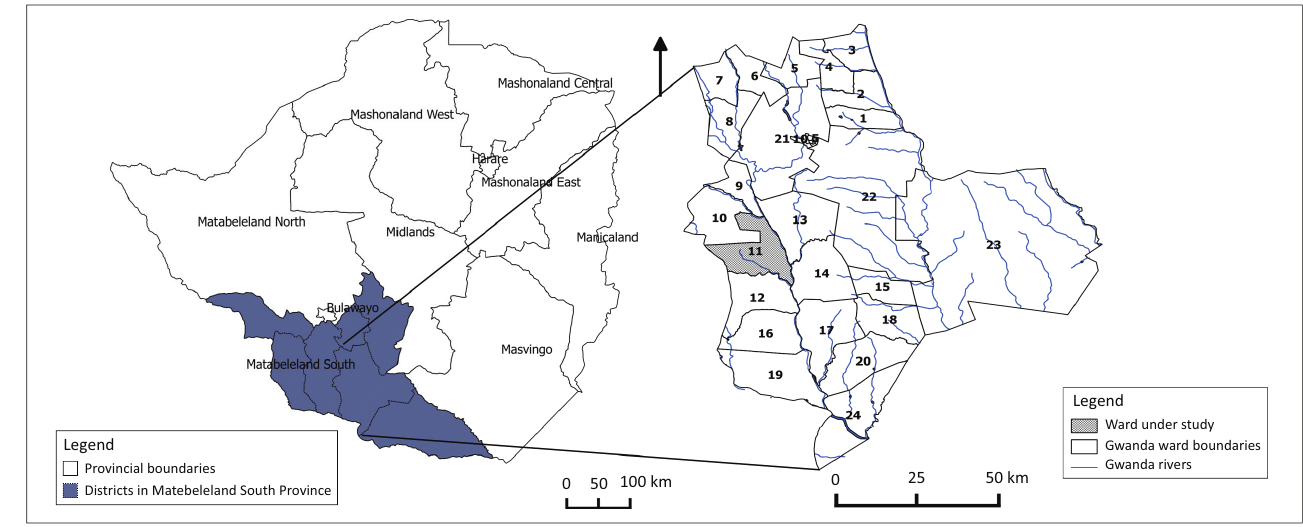
FIGURE 1: Map showing the location of Ntalale (Ward 11) in relation to Zimbabwe.